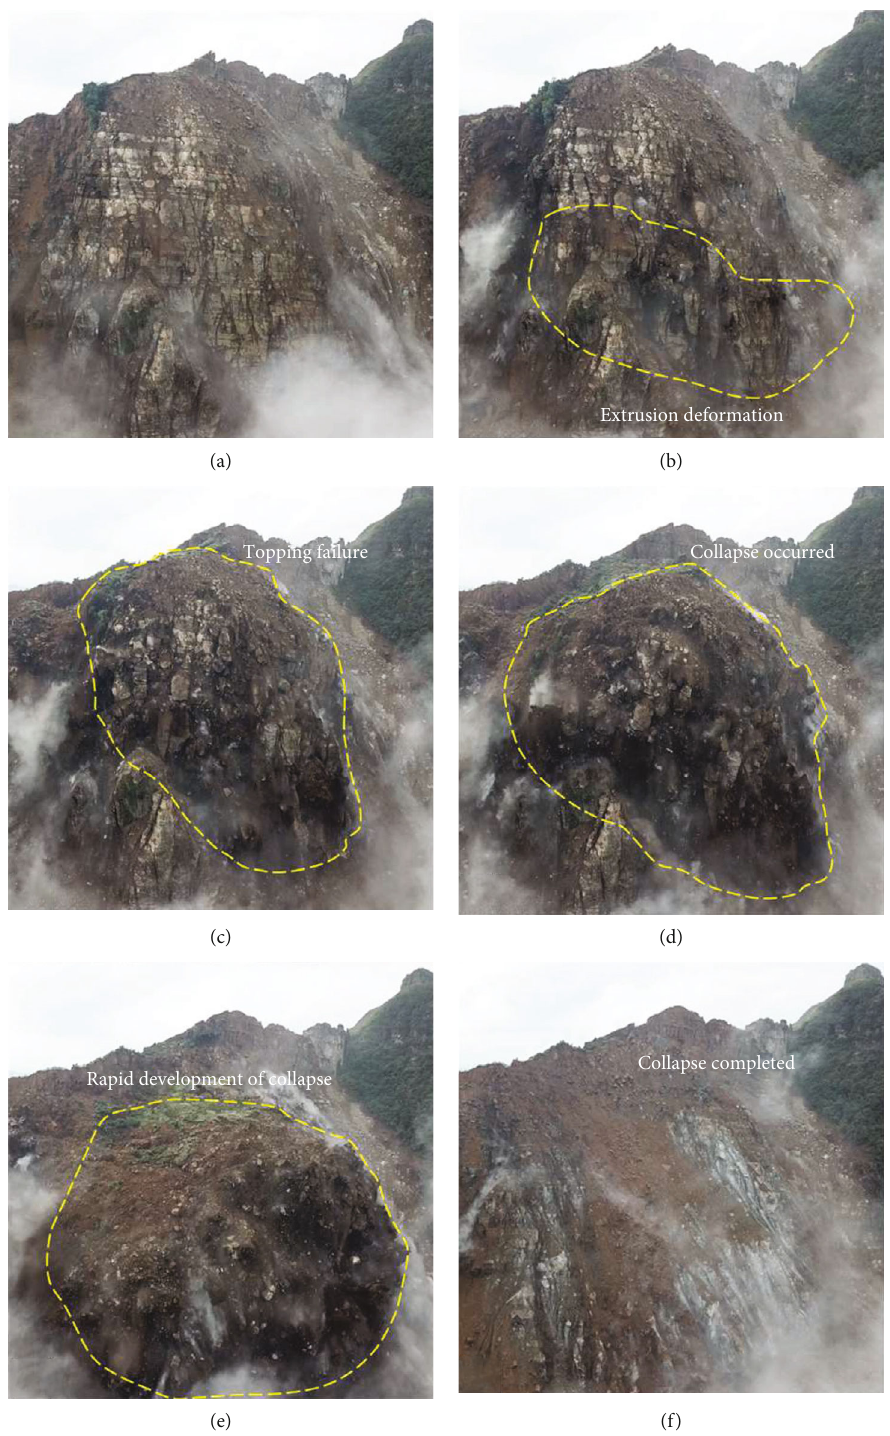
Figure 6: Eyewitness sample video frame for the progressive development of